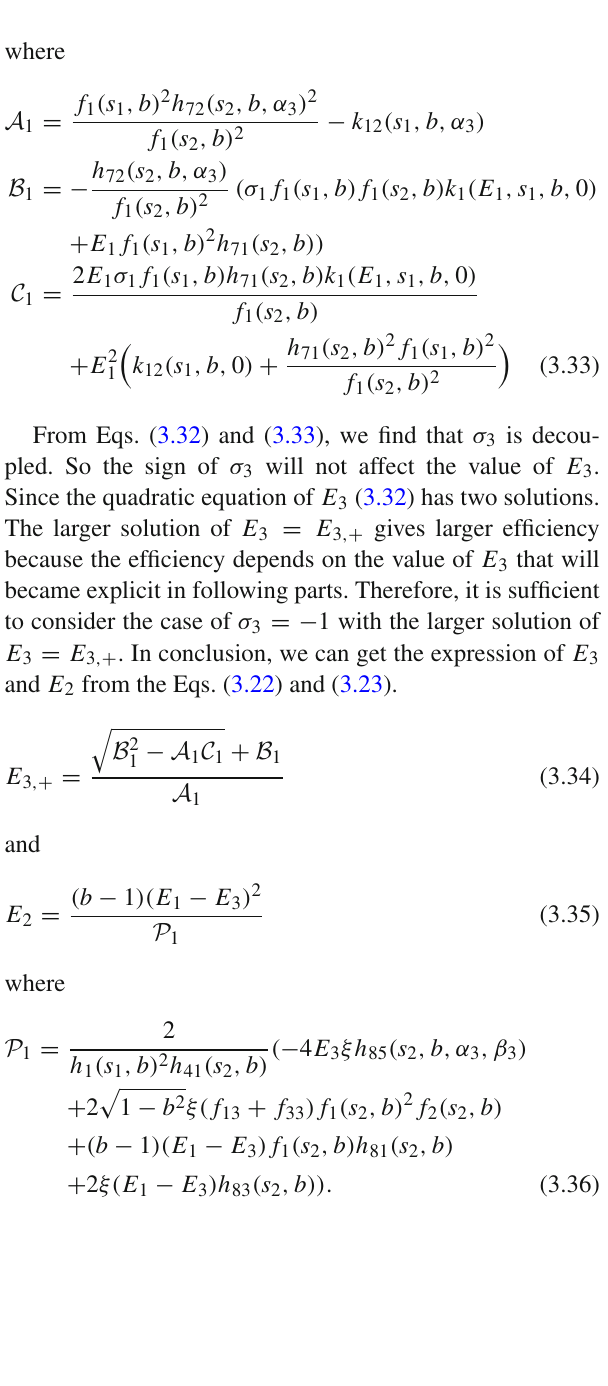
Fig. 3 The contour maps of E 3 in terms of α 3 and s 2 with s 1 = 0. a ( b = 0), b ( b = 0 . 1) and c ( b = 0 . 2) show that α 3 → 0 give larger value of E 3 when s 2 is small